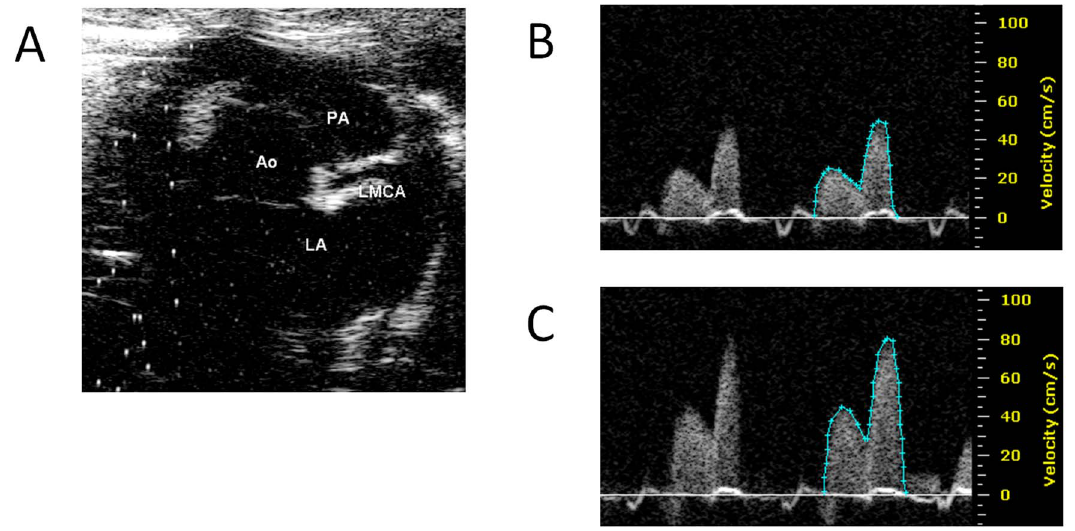
Figure 1. Measurement of coronary flow using Doppler echocardiography in rats. Parasternal short axis view of the heart (A) showing the Aorta (Ao), pulmonal artery (PA), left atrium (LA) and left main coronary artery (LMCA). Doppler velocity waveforms from the LMCA were traced and peak velocity and velocity time integrals were calculated during inhalation of 1.5% (B) and 3.5% (C) of isoflurane with oxygen.